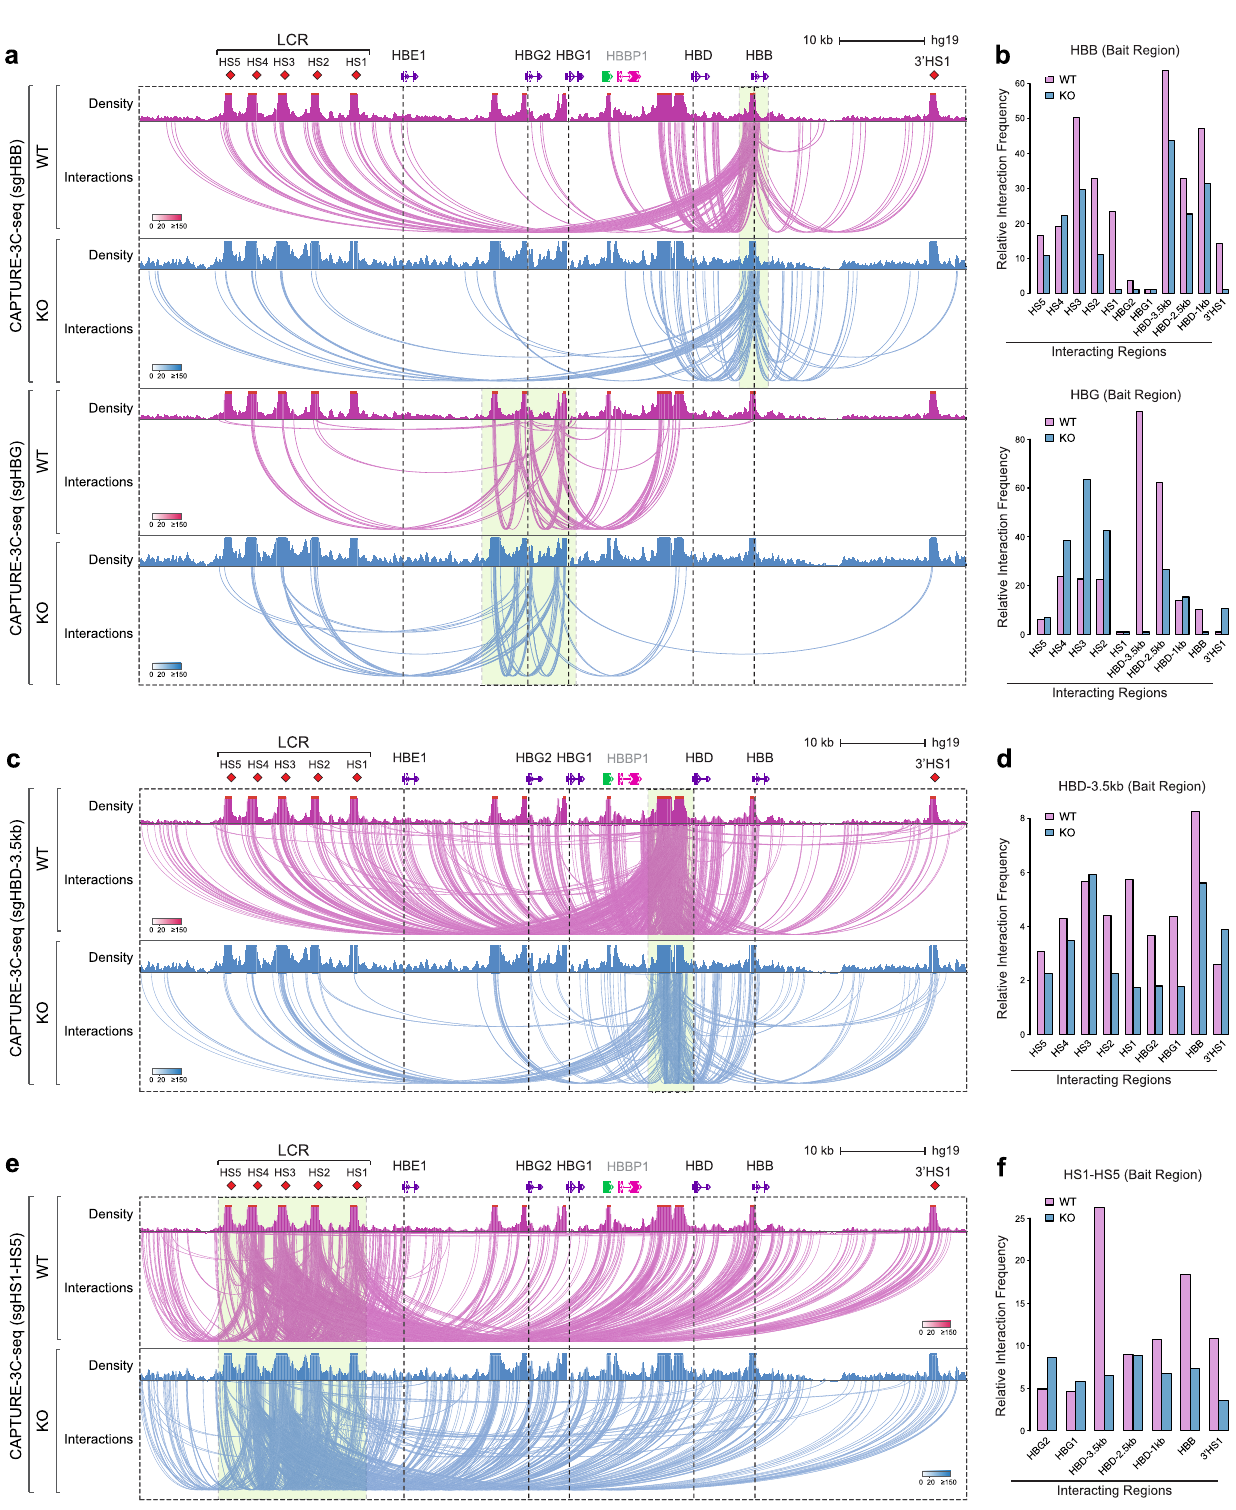
Fig. 4 Analysis of distinct β -globin locus cis -regulatory elements and BCL11A-dependent interactions using CAPTURE. a , c , e Genome browser view of long-range DNA interactions in WT (purple) vs BCL11A KO (blue) HUDEP-2 cells using HBB , HBG ( a ), HBD-HBG intergenic region ( c ), and LCR (HS1-HS5) ( e ) as the capture bait region, respectively. b , d , f Quantitative analysis of relative interaction frequency between the captured bait and the interacting regions. Three anchor sites in the HBD -3.5kb interval region are shown as − 3.5, − 2.5, and − 1 kb sites upstream of HBD